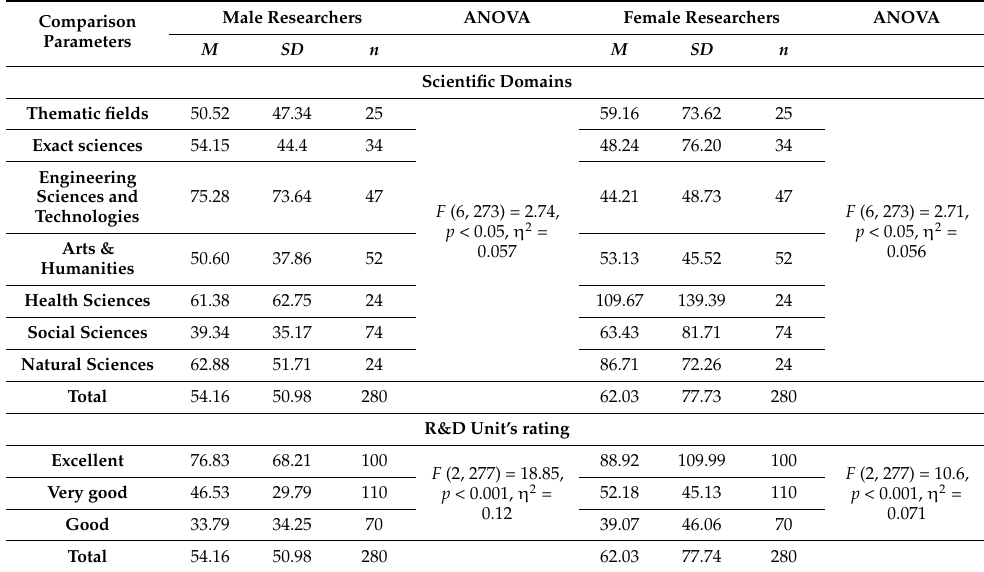
Table 8. Differences in means by scientific domains and classification of units according to the number of men and women in the teams